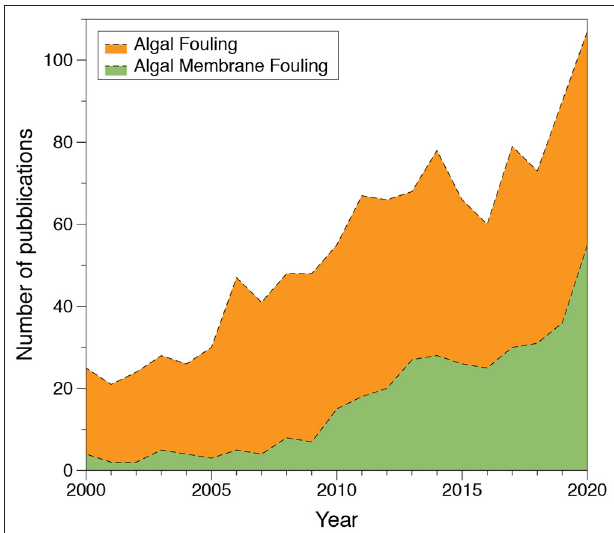
FIGURE 1 | Number of publications reported in the Scopus database on the topics of algal fouling.